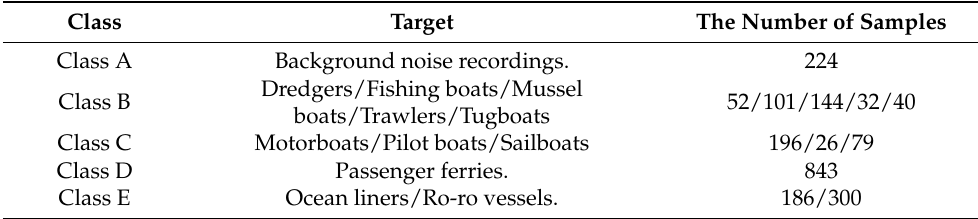
Table 1. The details of the five classes on the ShipsEar